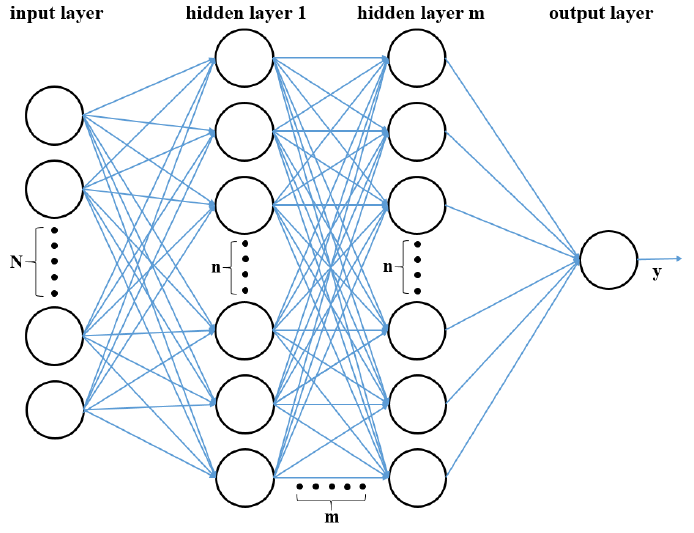
Figure 5. Architecture of the implemented neural networks.